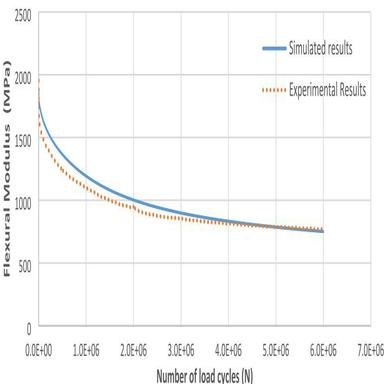
Comparison of simulated and experimental results: strain-controlled fatigue test .